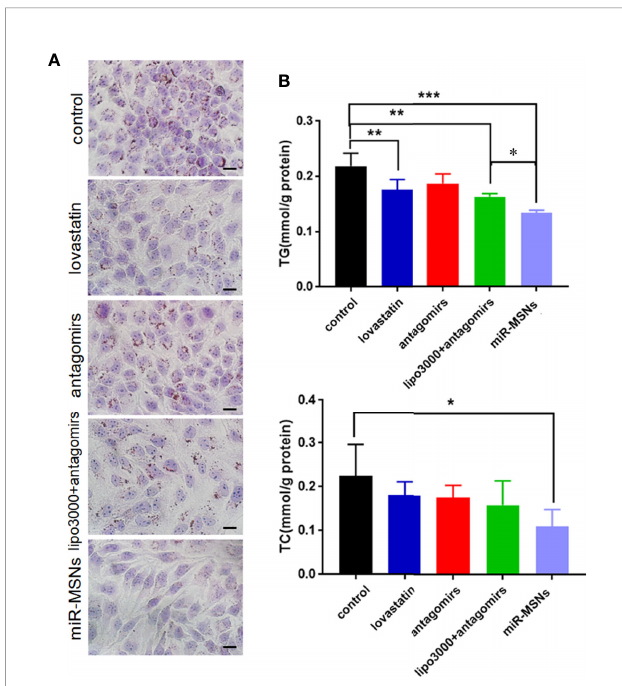
FIGURE 3 | Anti-steatosis activity of miR-MSNs in L02 cells. (A) Determination of lipid accumulation using Oil Red O. Scale bar = 20 µm. (B) TG and TC levels in the cells. n=3. *p < 0.05, **p < 0.01, and ***p < 0.001.